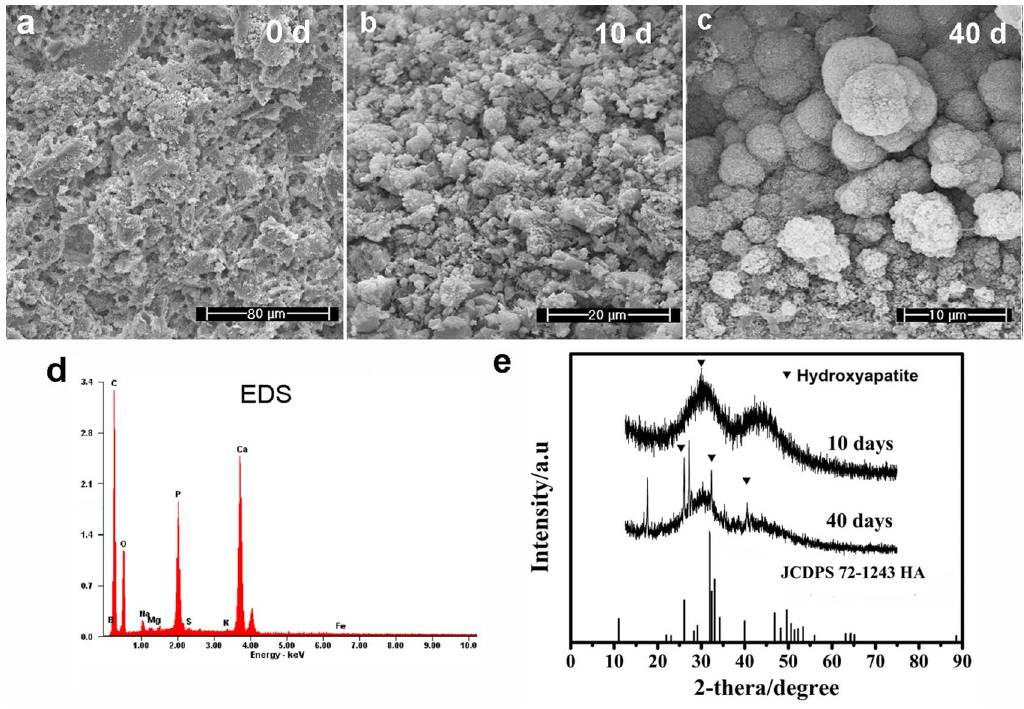
Figure 3. Characteristics of vancomycin-loaded borate BG cement in vitro. SEM images of the surface of vancomycin-loaded borate BG cement as fabricated (after hardening) (a) and after immersion in PBS for 10 days (b) and for 40 days (c). EDS analysis showed that particles formed on the surface of the specimens were composed of Ca and P (d). After immersion in PBS for 40 days, the XRD pattern of the samples showed similar peaks to those characteristic of reference hydroxyapatite (JCPDS 72–1243) (e).